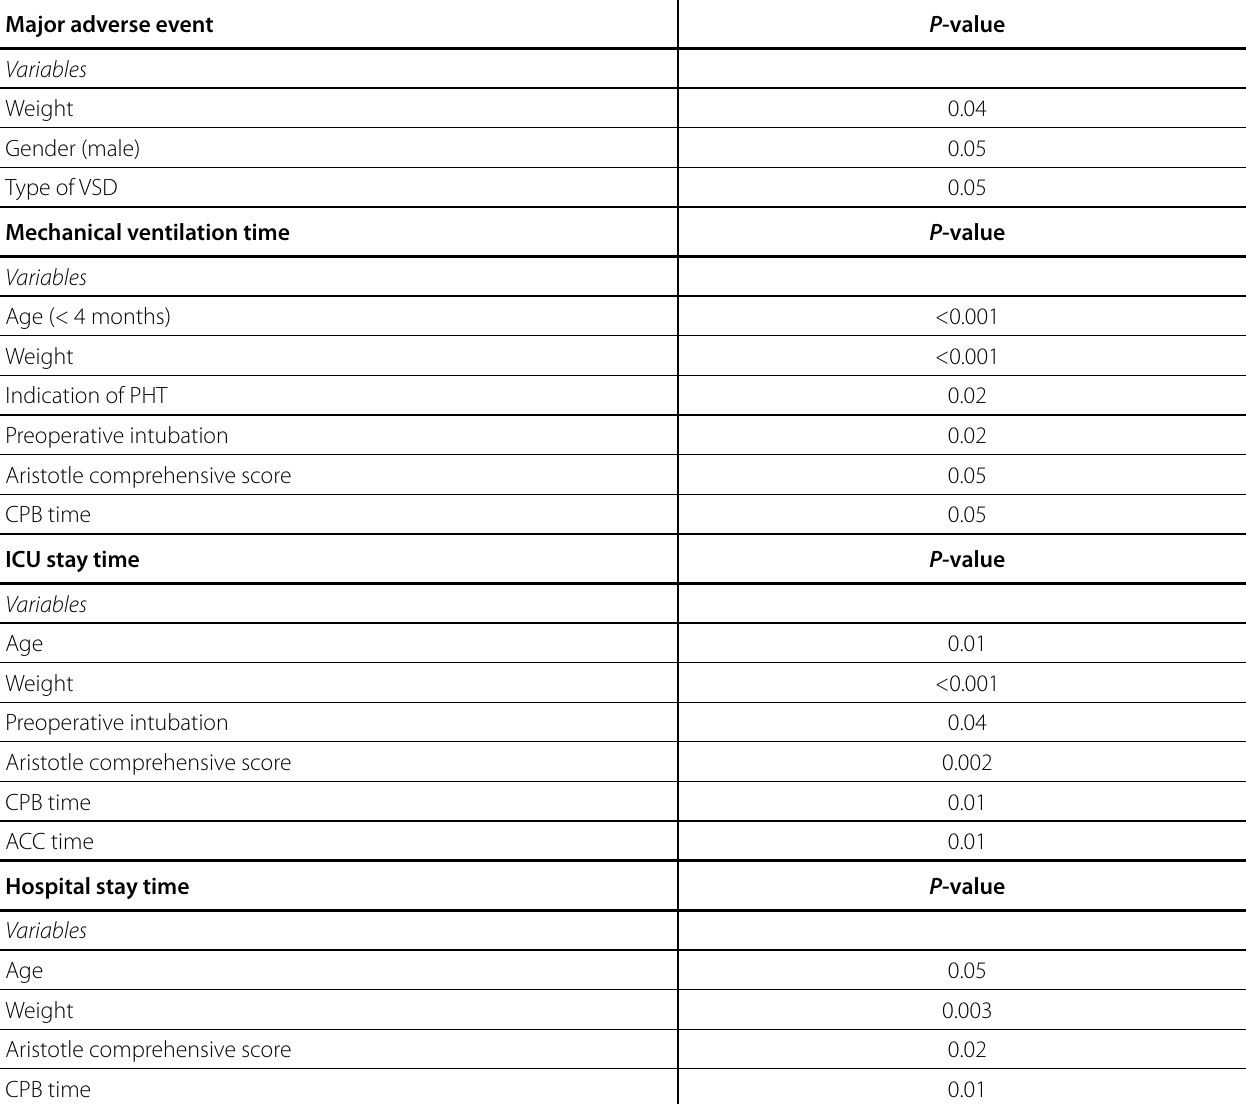
Table 3 . Univariate analysis for major adverse event, prolonged ventilation time, prolonged intensive care unit (ICU) stay time, and prolonged hospital stay